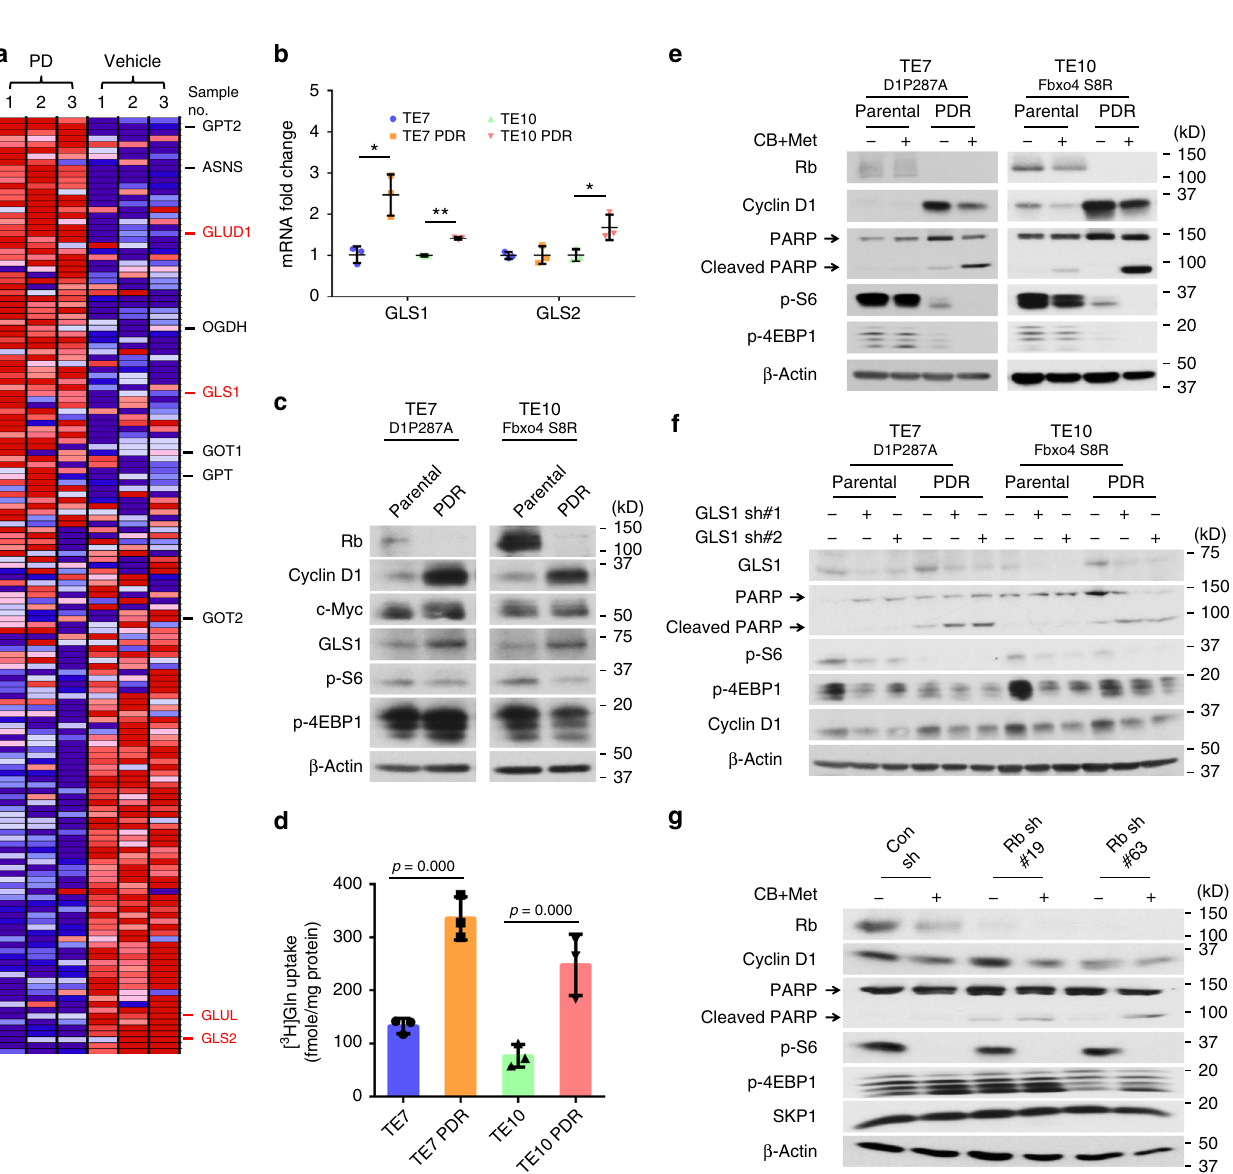
(Supplementary Fig. 18). Phenotypically, both TE7PDR and